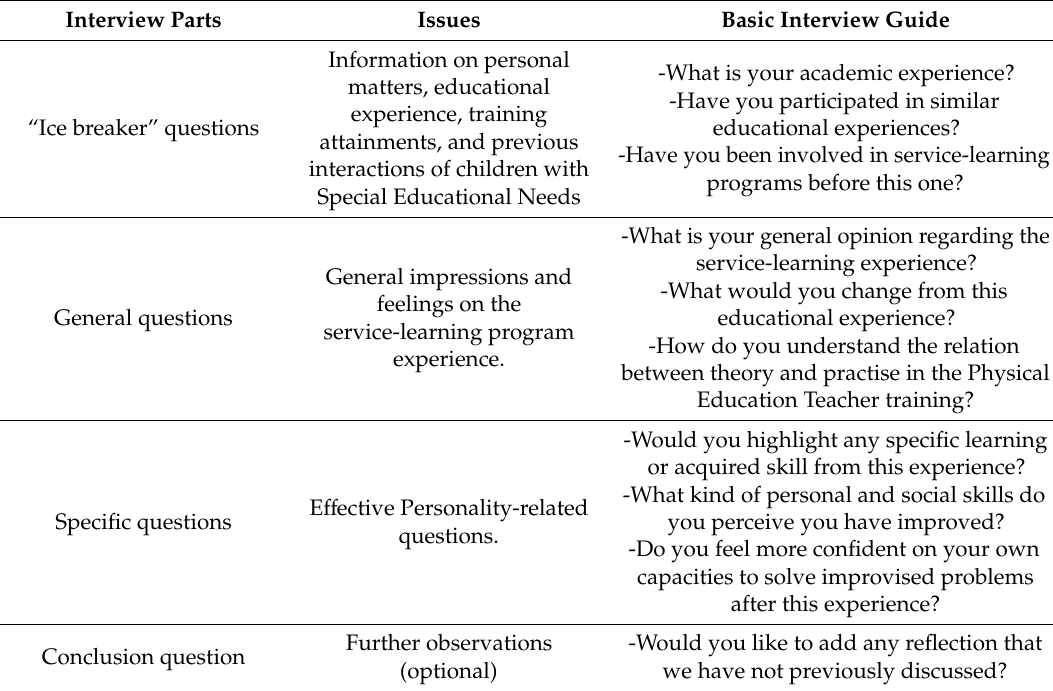
Table 2. The general scheme of the interviews carried